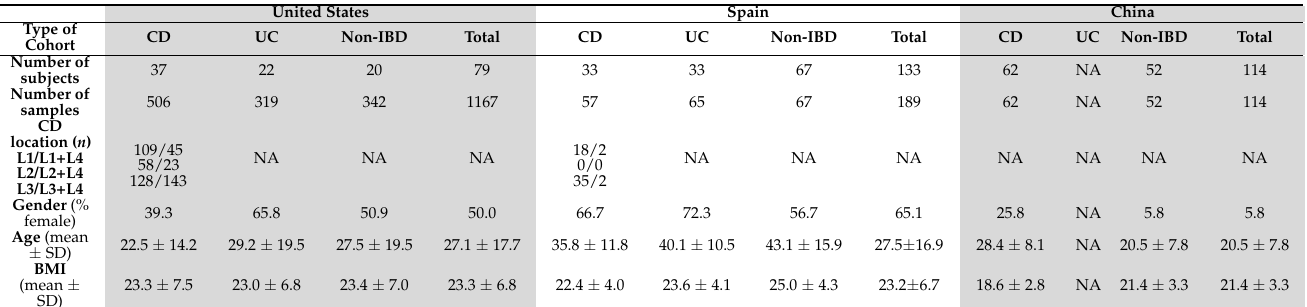
Table 1. Participants’